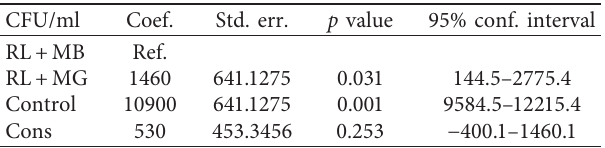
Figure 1: Linear regression analysis. Table 3: Linear regression of the antimicrobial effect of the red laser using different